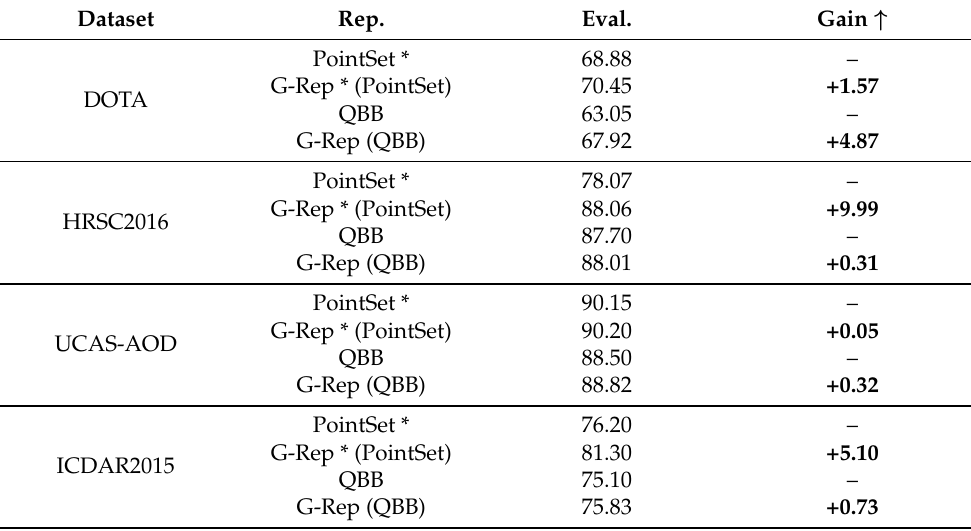
Table 5. Ablation study of G-Rep for QBB representations on various datasets. The regression loss of G-Rep is the L KLD . “*” denotes that dynamic ATSS-based strategies are adopted. Dataset Rep. Eval. Gain